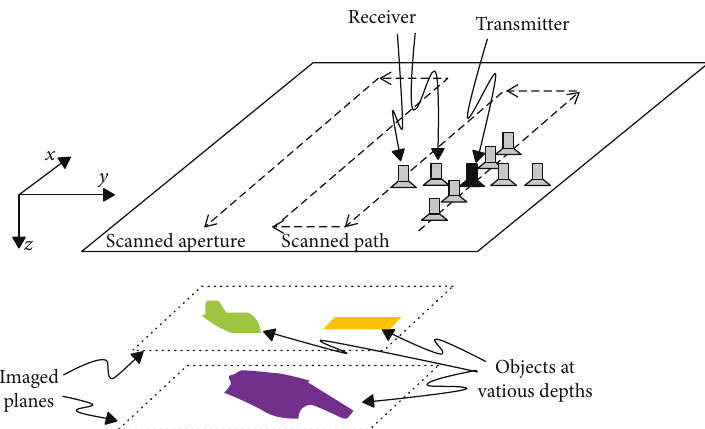
Figure 2: Illustration of the single frequency 3D holographic imaging setup which contains a transmitting antenna that illuminates the inspected medium with microwave power at a single frequency and when moving with an array of N r receiver antennas. This transmitter- receiver set scans a rectangular